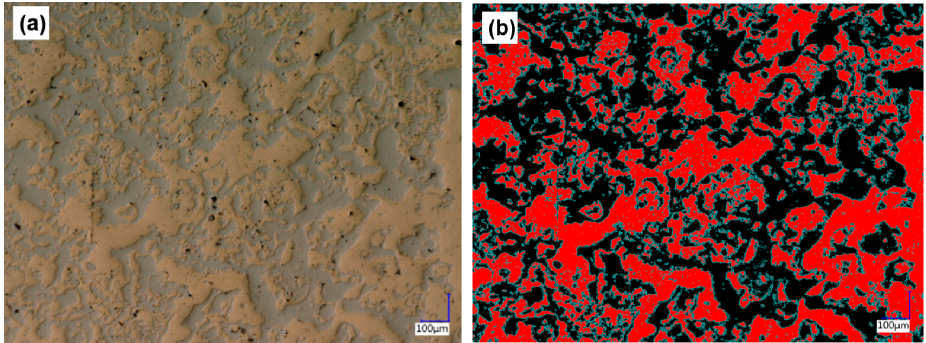
Figure 8. ( a ) 3D topography of the polished coating; ( b ) comparison chart of different components on the coating surface.